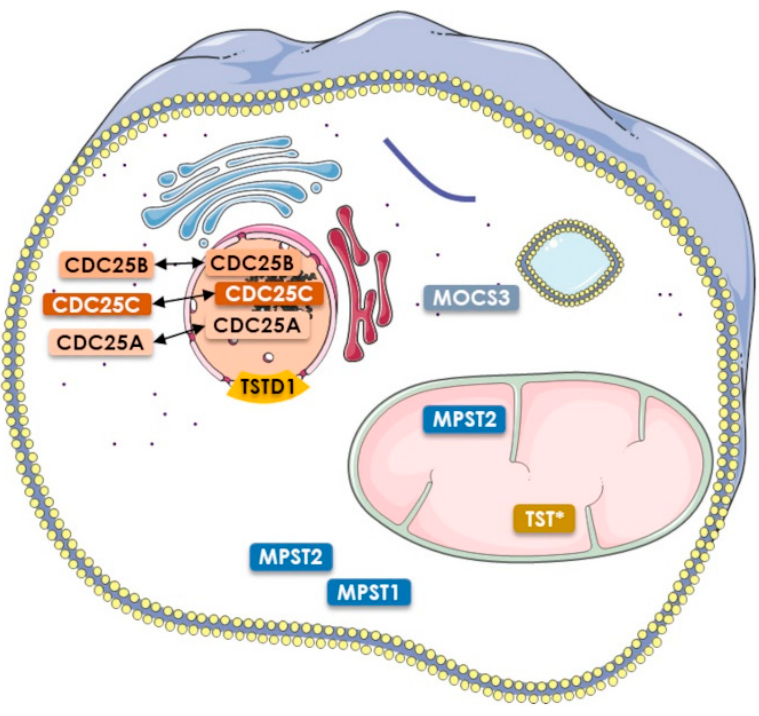
Figure 4. Reported sub-cellular localizations of human Rhd-containing proteins representatives [24,26–34].